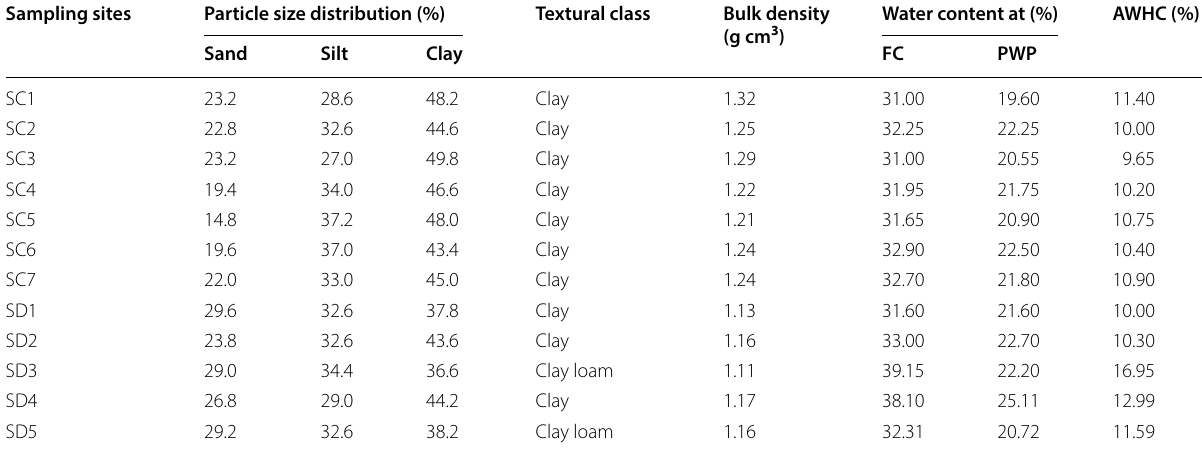
Table 2 Selected physical properties of the soils studied